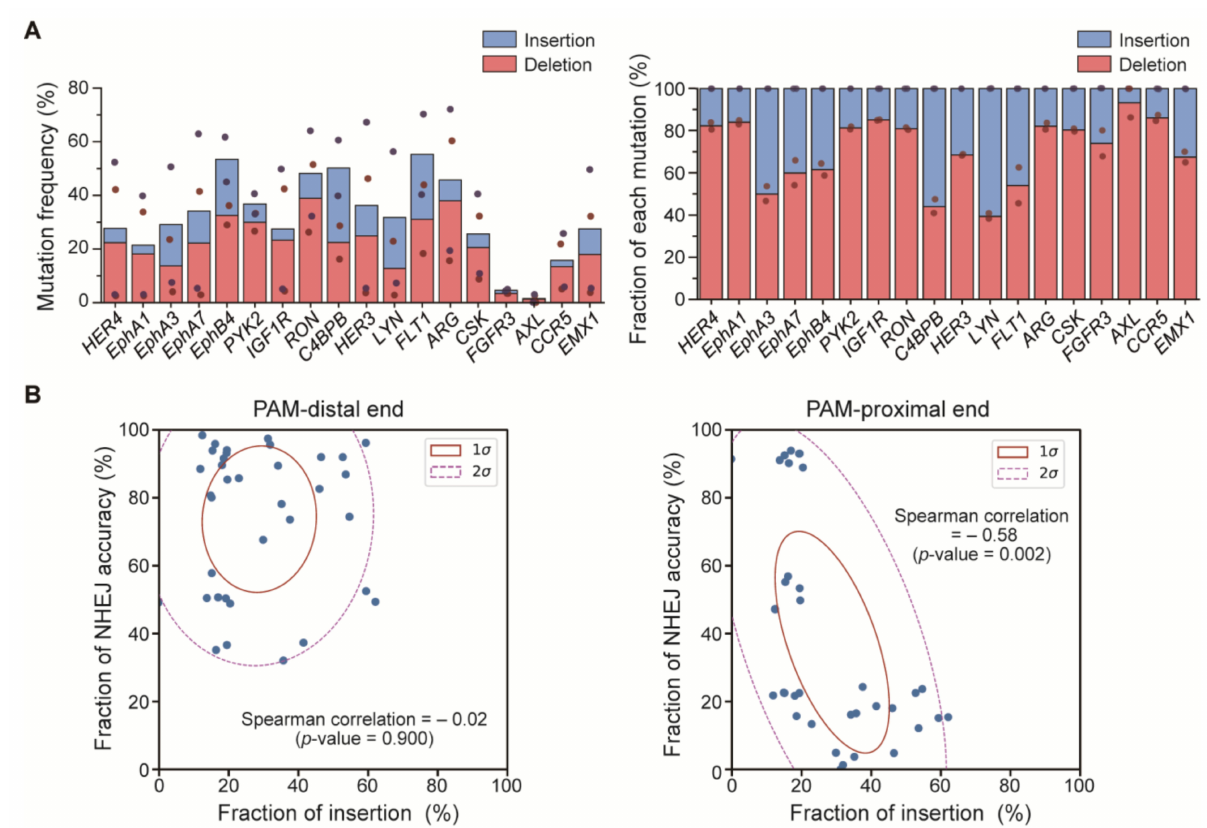
Figure 4. Correlation between the repair accuracy and the ratio of insertion mutation and deletion mutation. ( A ) ( Left ) The frequency of each type of mutation. ( Right ) The relative fraction of the insertion and the deletion. ( B ) Correlation between the repair accuracy and the fraction of insertion mutation in the PAM-distal end and the PAM-proximal end in HEK 293T cells (PAM-distal, R 2 = − 0.02, p = 0.900, Spearman correlation; PAM-proximal, R 2 = − 0.58, p = 0.002, Spearman